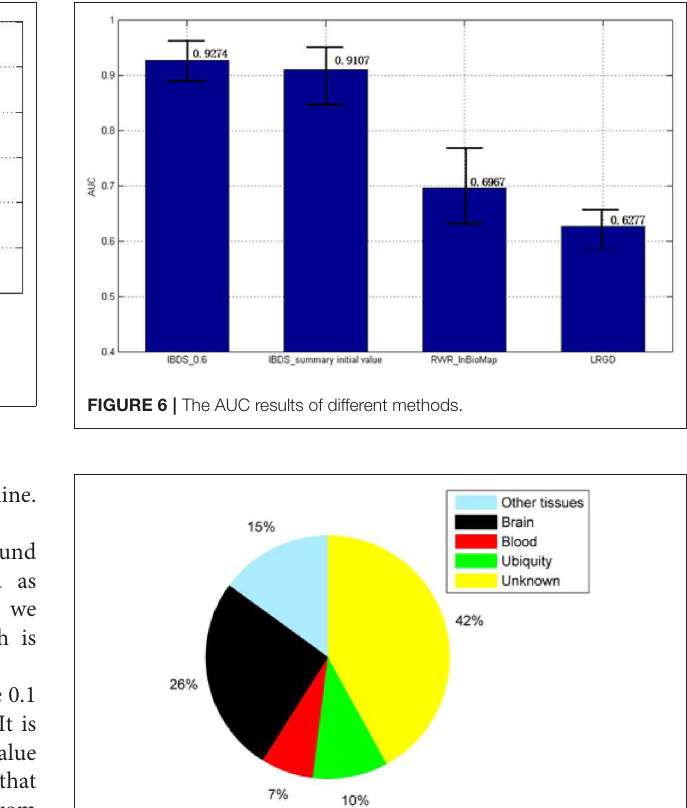
FIGURE 7 | The distribution of novel proteins’ tissue specificity.